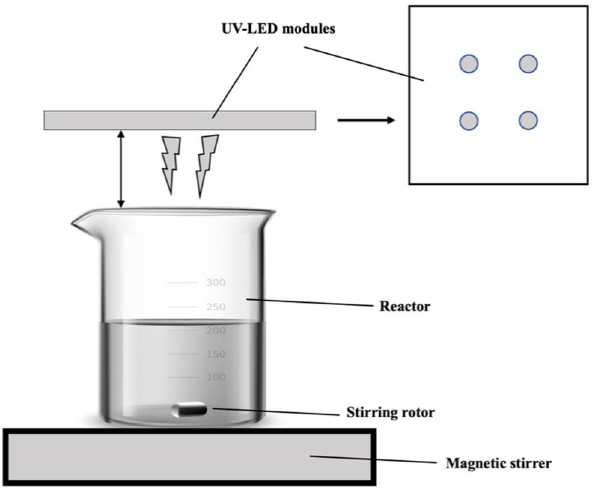
Figure 1. Schematic diagram of UV-LED reactors.